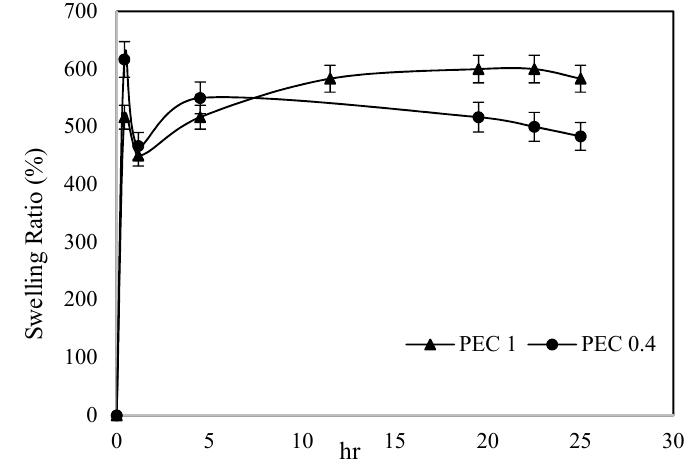
Figure 4. Swelling ratio of PEC films.